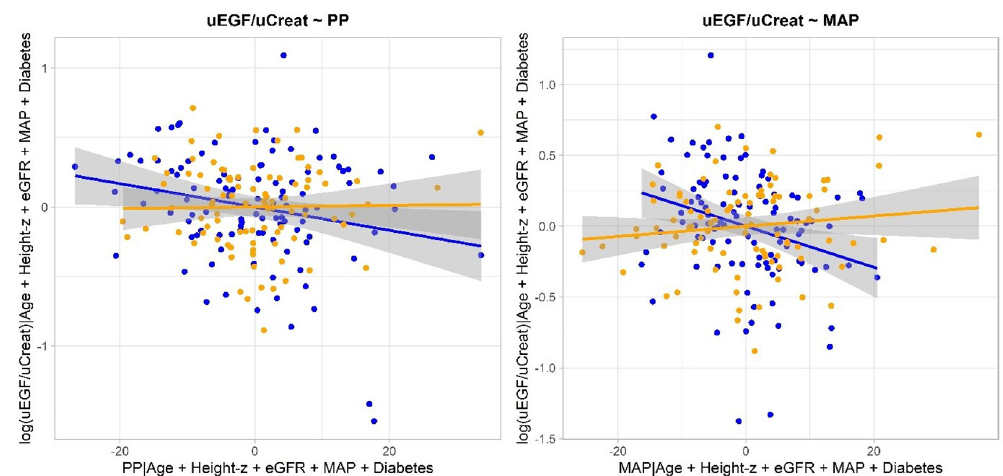
Fig 2. The added variable plots visualize the relation between uEGF/uCreat and respectively PP and MAP, after correction for the other covariates in the linear regression model (i.e. age, height z-score, eGFR and diabetes). The darker (blue) dots and lines correspond with the boys, while the lighter (orange) dots and lines depict the girls. As seen in the model, no clear relationship is seen for the girls, while in the boys we see a negative association between uEGF/uCreat and PP or MAP. MAP: mean arterial pressure; PP: pulse pressure; EGF: epidermal growth factor.